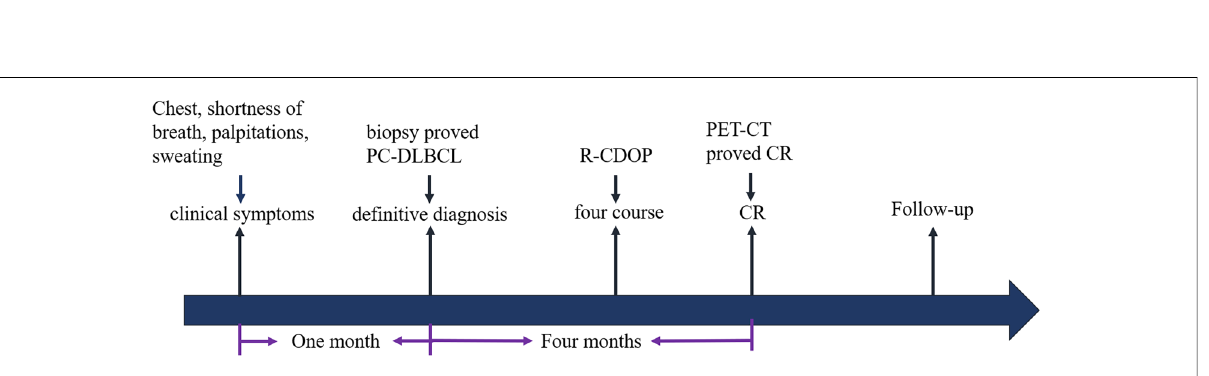
FIGURE 4 Flow chart of the patient ’ s clinical course: the patient ’ s timeline of the onset of clinical symptoms, de fi nitive diagnosis, treatment, and tumor response. CR, complete